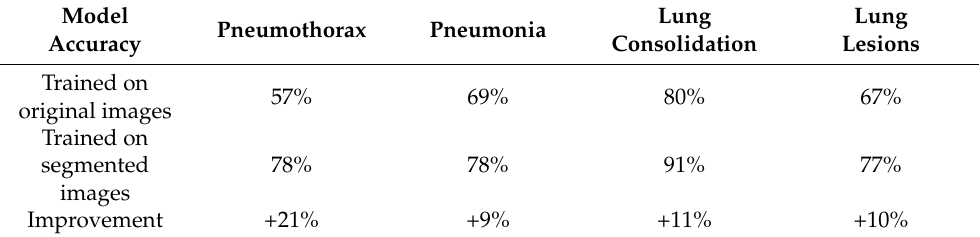
Table 2. Difference in accuracies depending on training model on segmented or original images.